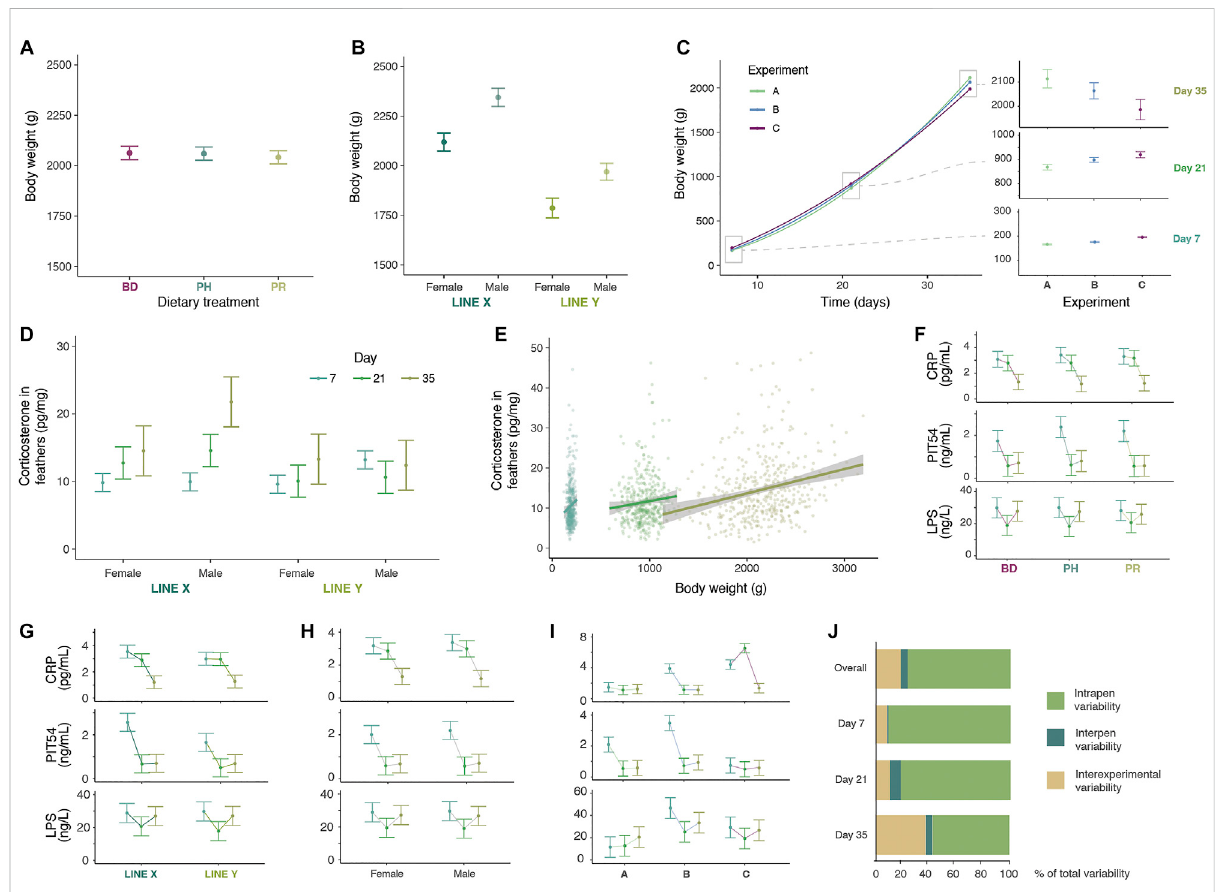
FIGURE 2 Overview of main results. (A) Body weight differences across dietary treatments, namely basal diet (BD), BD plus probiotic (PR) and BD plus phytobiotic (PH), at day 35. (B) Body weight differences across lines and sexes at day 35. (C) Body weight progression of the three experiments, with detailed overview of days 7, 21 and 35. (D) Corticosterone (COR) levels measured in feathers at different days, sexes, and genetic lines. (E) Linear correlation between COR levels and body weight at the three time points. (F) C-reactive protein (CRP), avian haptoglobin-like protein (PIT54) and lipopolysaccharide (LPS) levels in plasma across time points in different dietary treatments. (G) CRP, PIT54 and LPS levels in plasma across time points in different genetic lines. (H) CRP, PIT54 and LPS levels in plasma across time points in different sexes. (I) CRP, PIT54 and LPS levels in plasma across time points in different experiments. (J) Hierarchical decomposition of observed body weight variation within pens, among pens and among